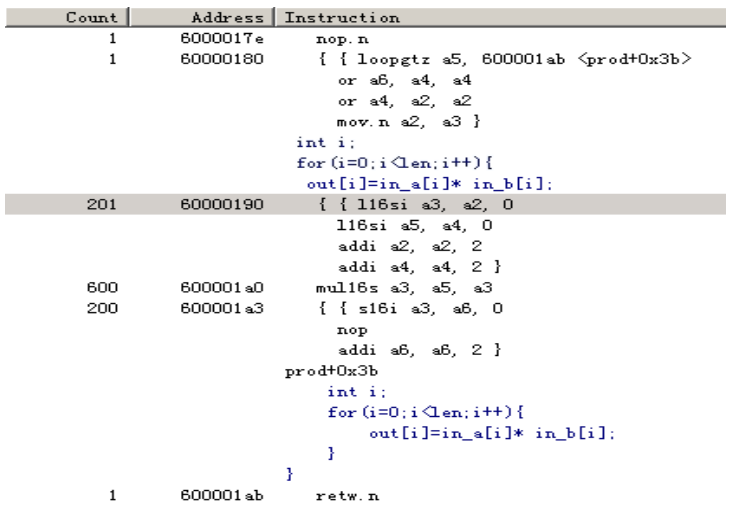
Algorithm 2. Calculate the dot product of two one-dimensional vectors of size 200